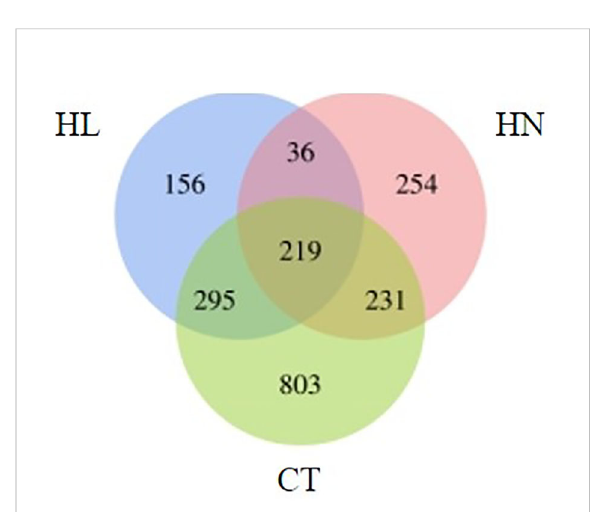
FIGURE 3 Venn diagram of the number of genes associated with H3K4me3 under different conditions: high light (HL), high nitrogen (HN), and normal f/2 medium condition